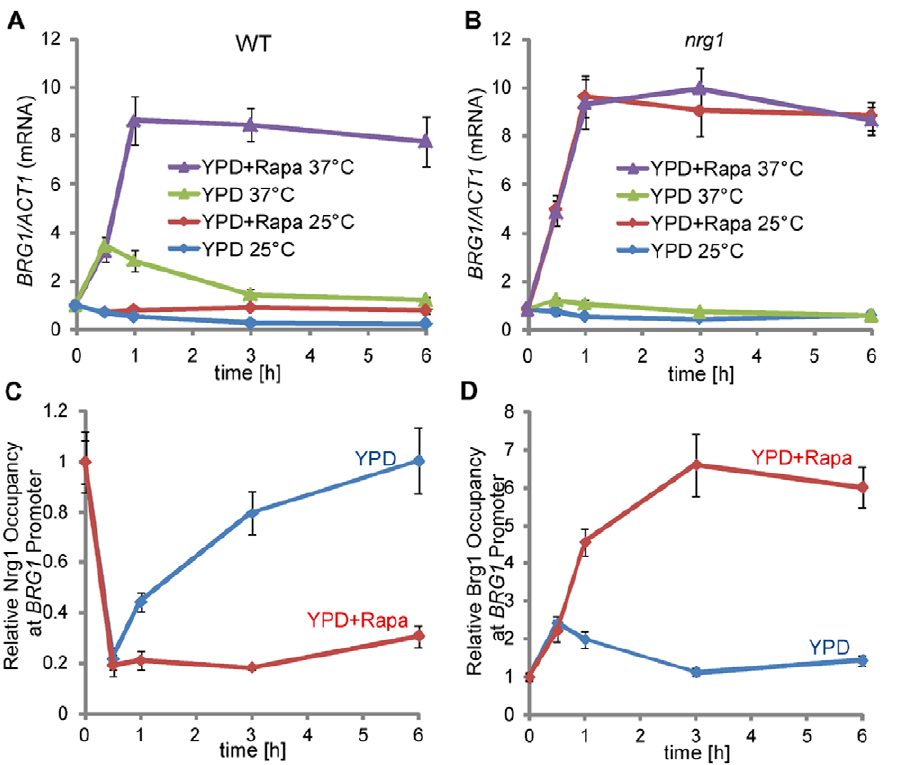
Figure 3. BRG1 expression is controlled by both removal of Nrg1 repression and rapamycin-dependent activation. qRT-PCR analysis of BRG1 expression in wild type (A) and in the nrg1 mutant (B). Cells were diluted 1:250 fold into pre-warmed YPD medium at 25 u C or 37 u C in the presence or absence of 10 nM rapamycin. BRG1 mRNA levels were determined by qRT-PCR. The signals obtained from ACT1 mRNA were used for normalization. The 0 h normalized value of BRG1/ACT1 for the wild type was set to be 1.00, and used for normalization of all other values in A and B. ChIP time courses of Nrg1-Myc (HLY3922) and Brg1-Myc (HLY4082) are shown in C and D, respectively. Cells were diluted into YEPD medium at 37 u C in the presence or absence of 10 nM rapamycin. ChIP DNA were quantitated by qPCR with primers at 2 1959 , 2 1710 bp of the BRG1 promoter as described in Figure 1. All data show an average of three independent qRT-PCR or qPCR experiments with error bars representing the SEM.